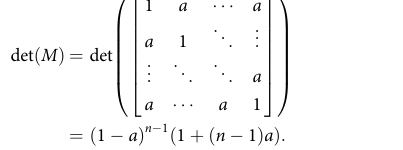
ffiffiffiffiffiffi p (cid:8) (cid:9) T ffiffiffiffiffiffiffiffiffiffiffiffiffiffi C D 1